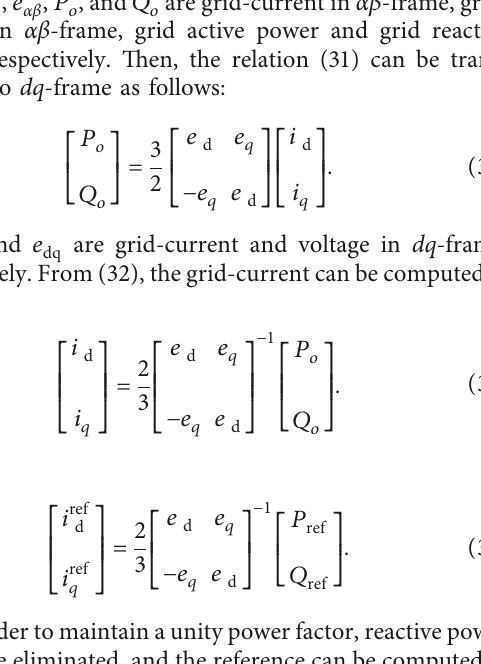
Table 1: Simulation